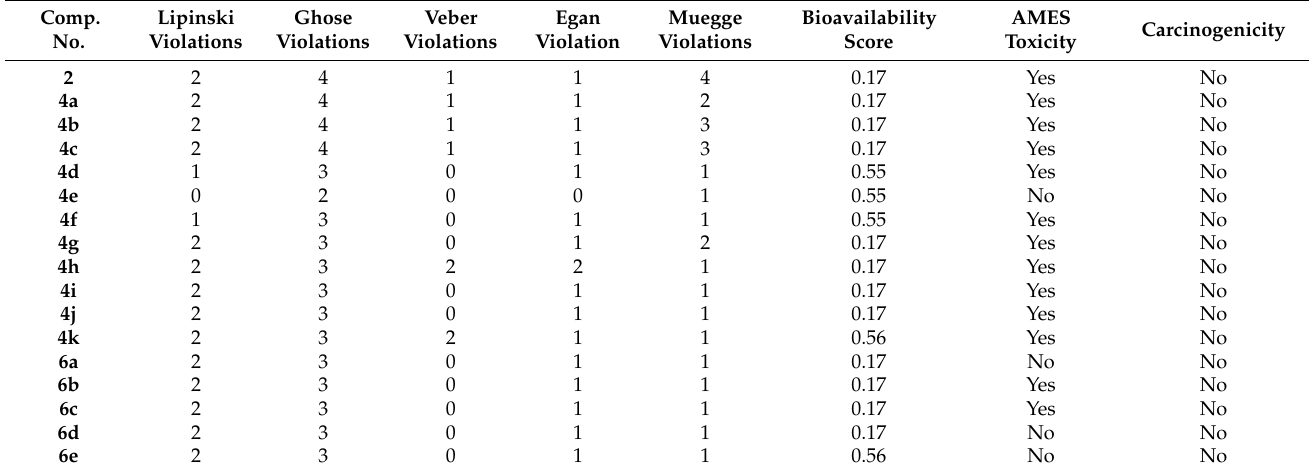
Table 4. Drug-likeness and toxicity predictions of the selected compounds.